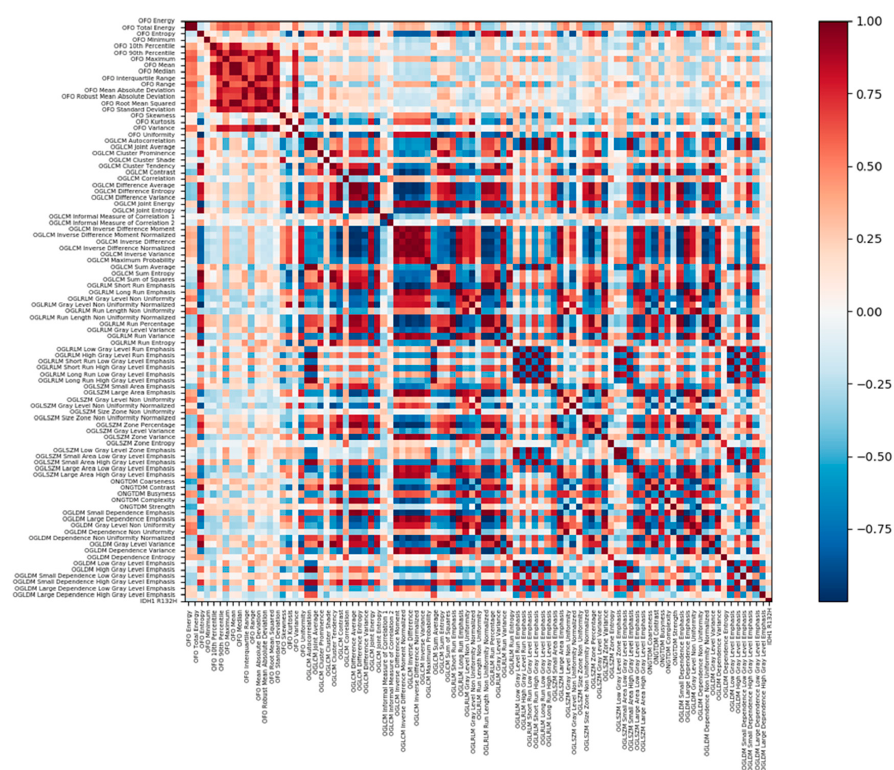
Figure A2. Spearman Correlation Matrix of FLAIR Radiomic Features.